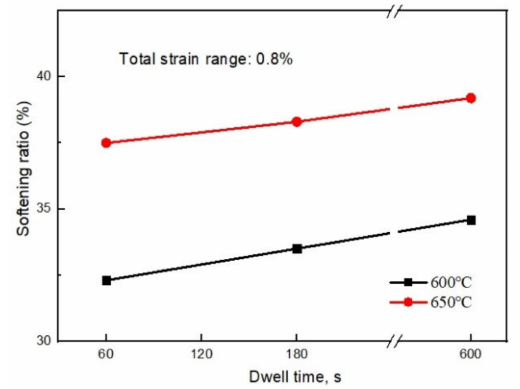
Figure 3. Cyclic softening curves of P92 steel at di ff erent dwell times.